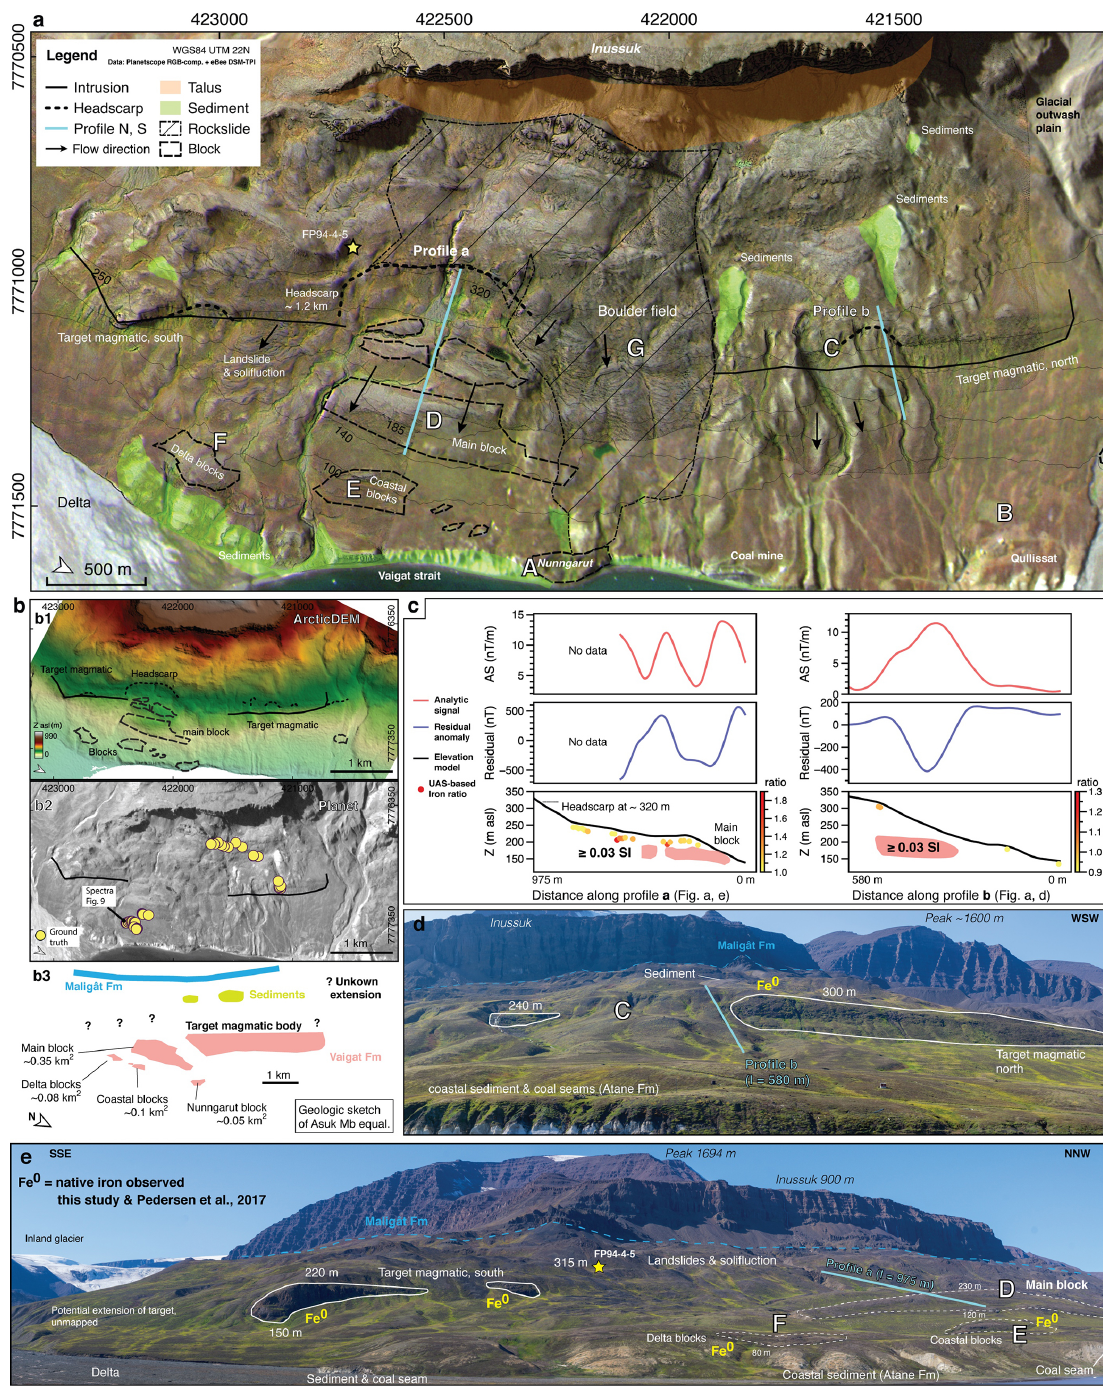
Figure 14. Integrated interpretation (a) RGB-composite plot from PlanetScope images (Planet Team, 2017) that are merged with semi- transparent TPI from the eBee DSM to increase image contrast. Landslide features are marked as dashed lines with thin lines for larger blocks and thick lines for the main landslide scarp. Talus below the Inussuk and block fields are the source for numerous boulders in the whole area. Mapped sediments reach up till the foot of the Inussuk cliff. (b) Overview maps illustrate area in relation to the different data: (b1) ArcticDEM at 2m resolution with interpreted blocks, (b2) PlanetScope greyscale mosaic with ground truth locations (spectroscopy and magnetic susceptibility) and (b3) sketch showing the assumed extent of the target magmatic body (only the part covered with UAS data are shown). (c) Two schematic cross sections in the west–east direction are shown together with the magnetic anomaly and the analytical signal from the UAS-borne magnetic data, and iron ratios extracted from the UAS-borne multi-spectral data. The locations of these cross sections are sketched in (a) . (d–e) Coast-side views onto the magmatic outcrops in the (d) northern and (e) southern part of the study area. Solid Earth, 13, 793–825, 2022